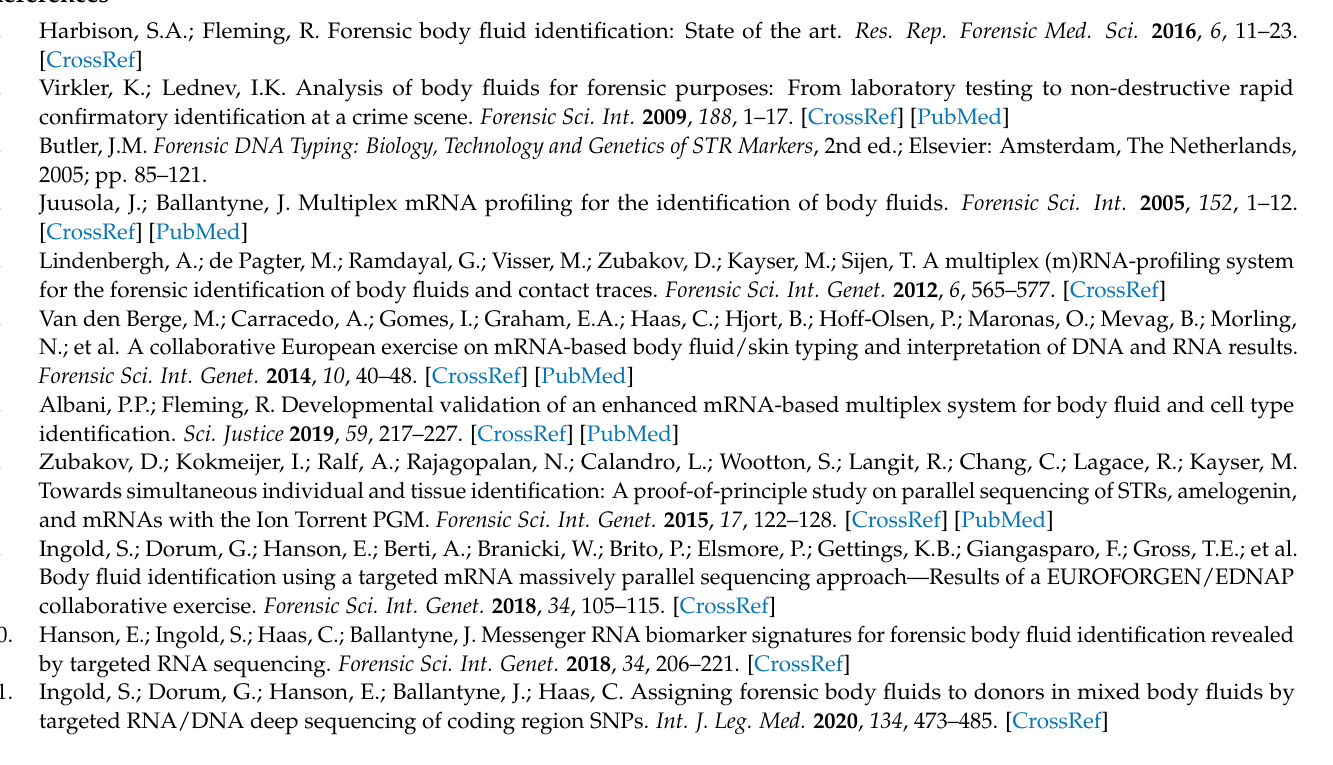
and cSNPs included in the panel; Table S2: The detection of gDNA PRM1 marker in seven samples; Figure S1: Dot plot showing the number of reads of the different body fluids detected in each sample; Figure S2: Scatter plot displaying the association of total reads per profile including all body fluid markers and RNA quant in samples; Figure S3: Scatter plot displaying the association of the number of reads for vaginal mucosa markers and RNA quantity in samples; Figure S4: The number of reads at each target for CYP2A6, CYP2B7P1 and MUC22 split into different time points and location of sampling; Figure S5: Scatter plot displaying the number of reads for the different vaginal mucosa cSNPs; Figure S6: Distribution of heterozygous balance observed in the cSNP genotypes for the different mRNA markers. Supplementary File S2: Data of cSNPs. Supplementary File S3: Data of MPS and CE